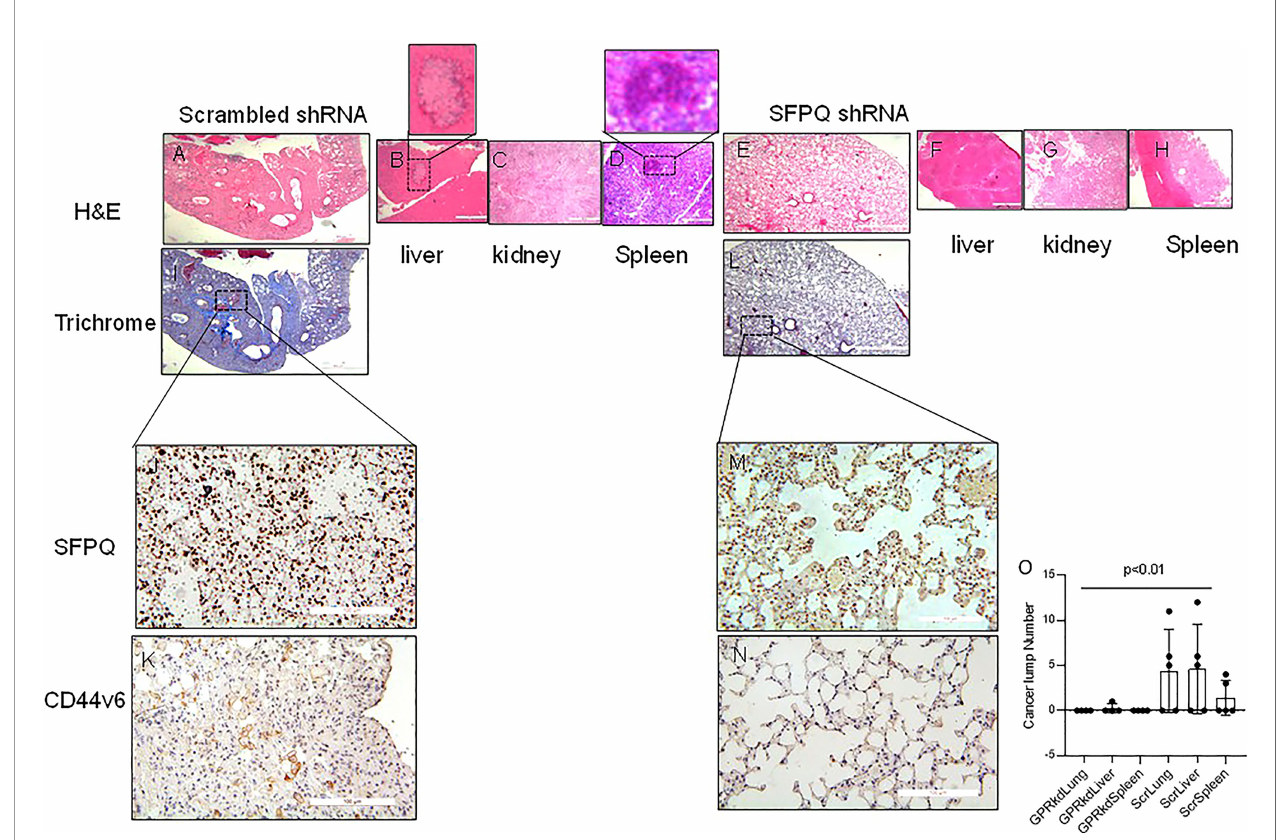
FIGURE 5 | SFPQ is essential for lung NSC cancer MSCs distant metastasis in vivo . NSG mice were used for cancer cell metastasis experiment. (A – N) . Serial 4 µm sections of the tissues from mice receiving A549 MSCs transduced with scrambled-shRNA (A – D, I) , scale bar: 200 µm; (J, K) scale bar 50 µm) or SFPQ-shRNA (E – H, L) , scale bar: 200 µm; (M, N) scale bar 50 µm). Representative H&E and Trichrome staining to assess fi brosis and cancer cell nests. IHC with anti-SFPQ antibody (J, M) and anti-CD44v6 antibody (K, N) was used to assess the distribution of cells expressing SFPQ and CD44v6 in the lung tissues of mice receiving A549 MSCs transduced with scrambled shRNA or SFPQ shRNA.. (O) . The tumor masses in the H&E staining from mouse lung, liver and spleen tissues were counted and summarized in fi gure O. Compared with mice received SFPQ-knocked down lung NSC cancer MSCs, the mice in the control group had more cancerous masses (Student T test,